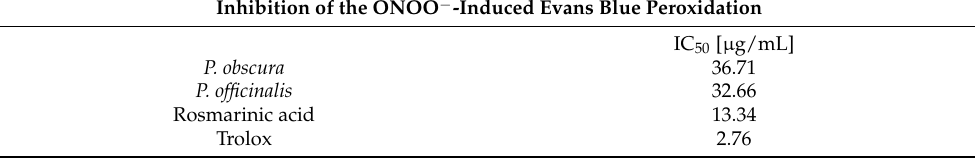
Table 3. Determination of the ONOO − scavenging abilities of P. obscura and P. officinalis phenolic-rich fractions, based on their inhibitory effects on the 1 mM ONOO − -induced bleaching (peroxidation) of Evans blue dye ( n =